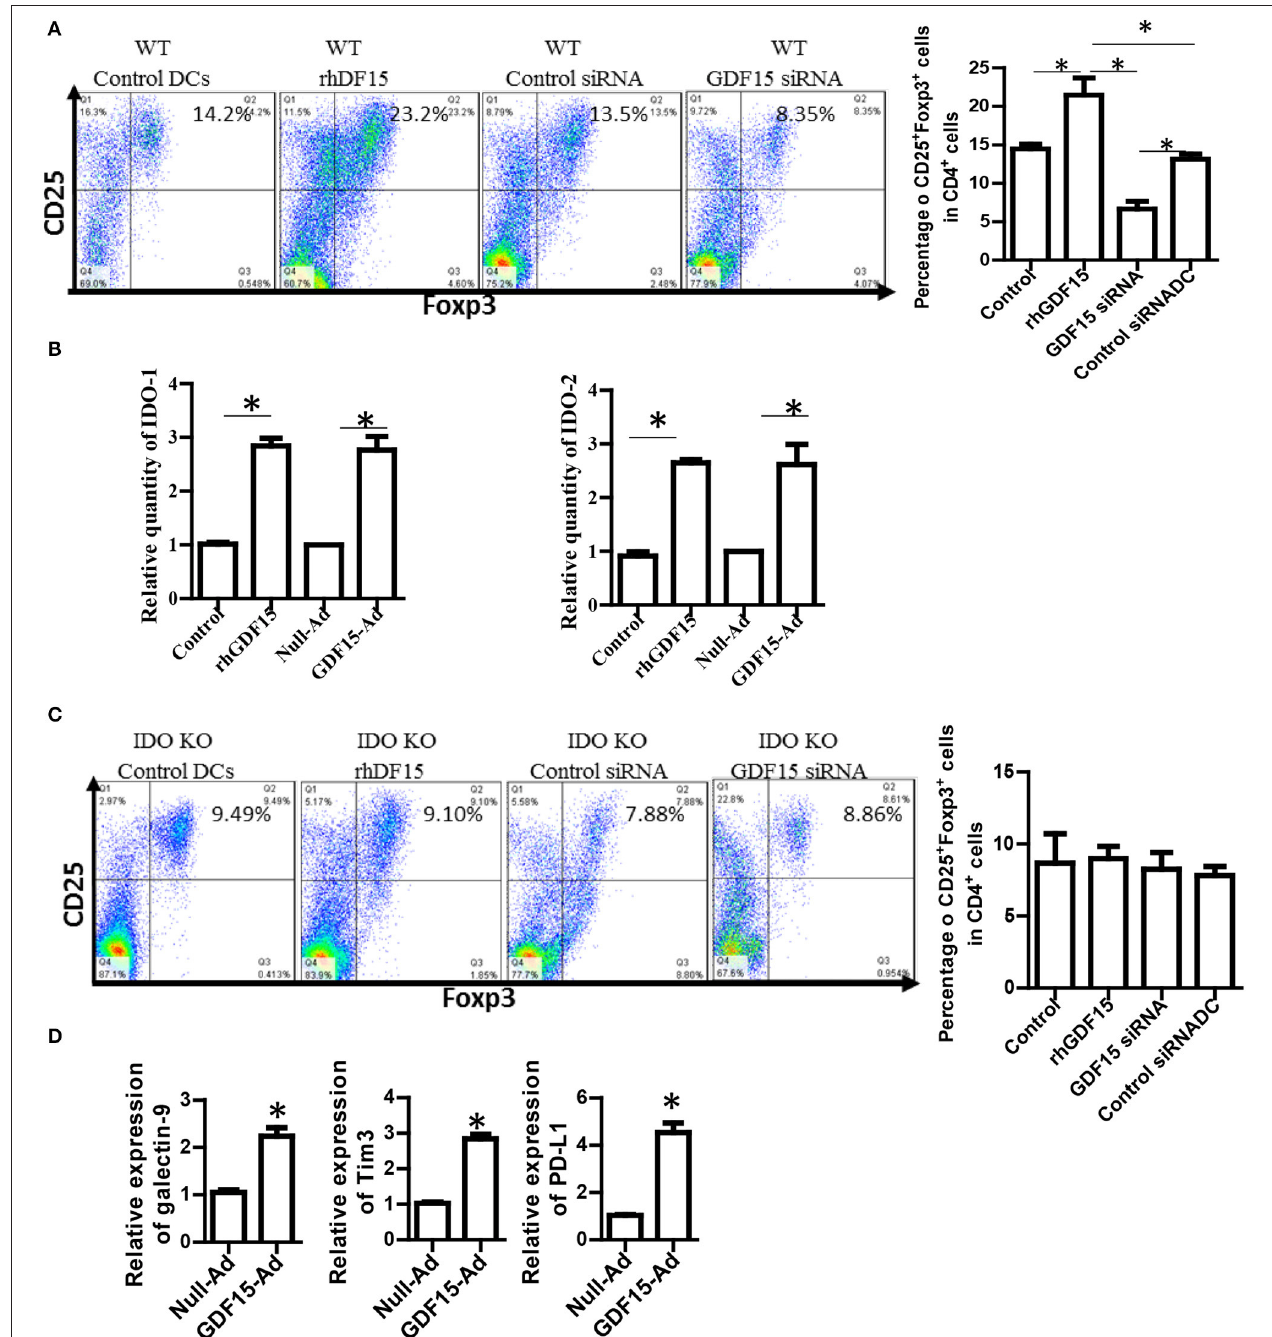
FIGURE 4 | GDF15 enhanced DCs ability to generate Tregs. (A) The effect of GDF15 on Tregs. DCs were cultured from WT mice and treated with rhGDF15 or GDF15 siRNA, or control GL2 siRNA. rhGDF15 treated DCs and GDF15 silenced DCs or untreated DCs or GL2 siRNA transfected DCs were co-cultured